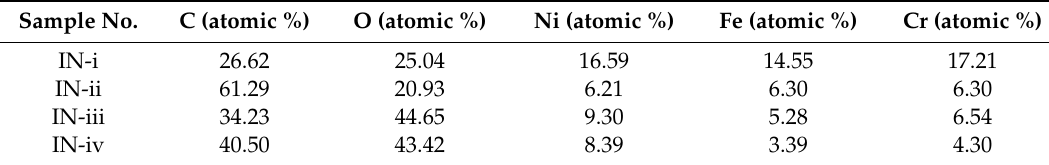
Figure 5. XPS spectra of survey scan: ( a ) fresh pristine IN718 surface, ( b ) aged pristine IN718 surface ( c ) line-patterned super-hydrophobic surface, ( d ) grid-patterned super-hydrophobic surface [23]. Figure 5c and 5d are reproduced with permission from Elsevier. Table 3. Elemental components detected by XPS.